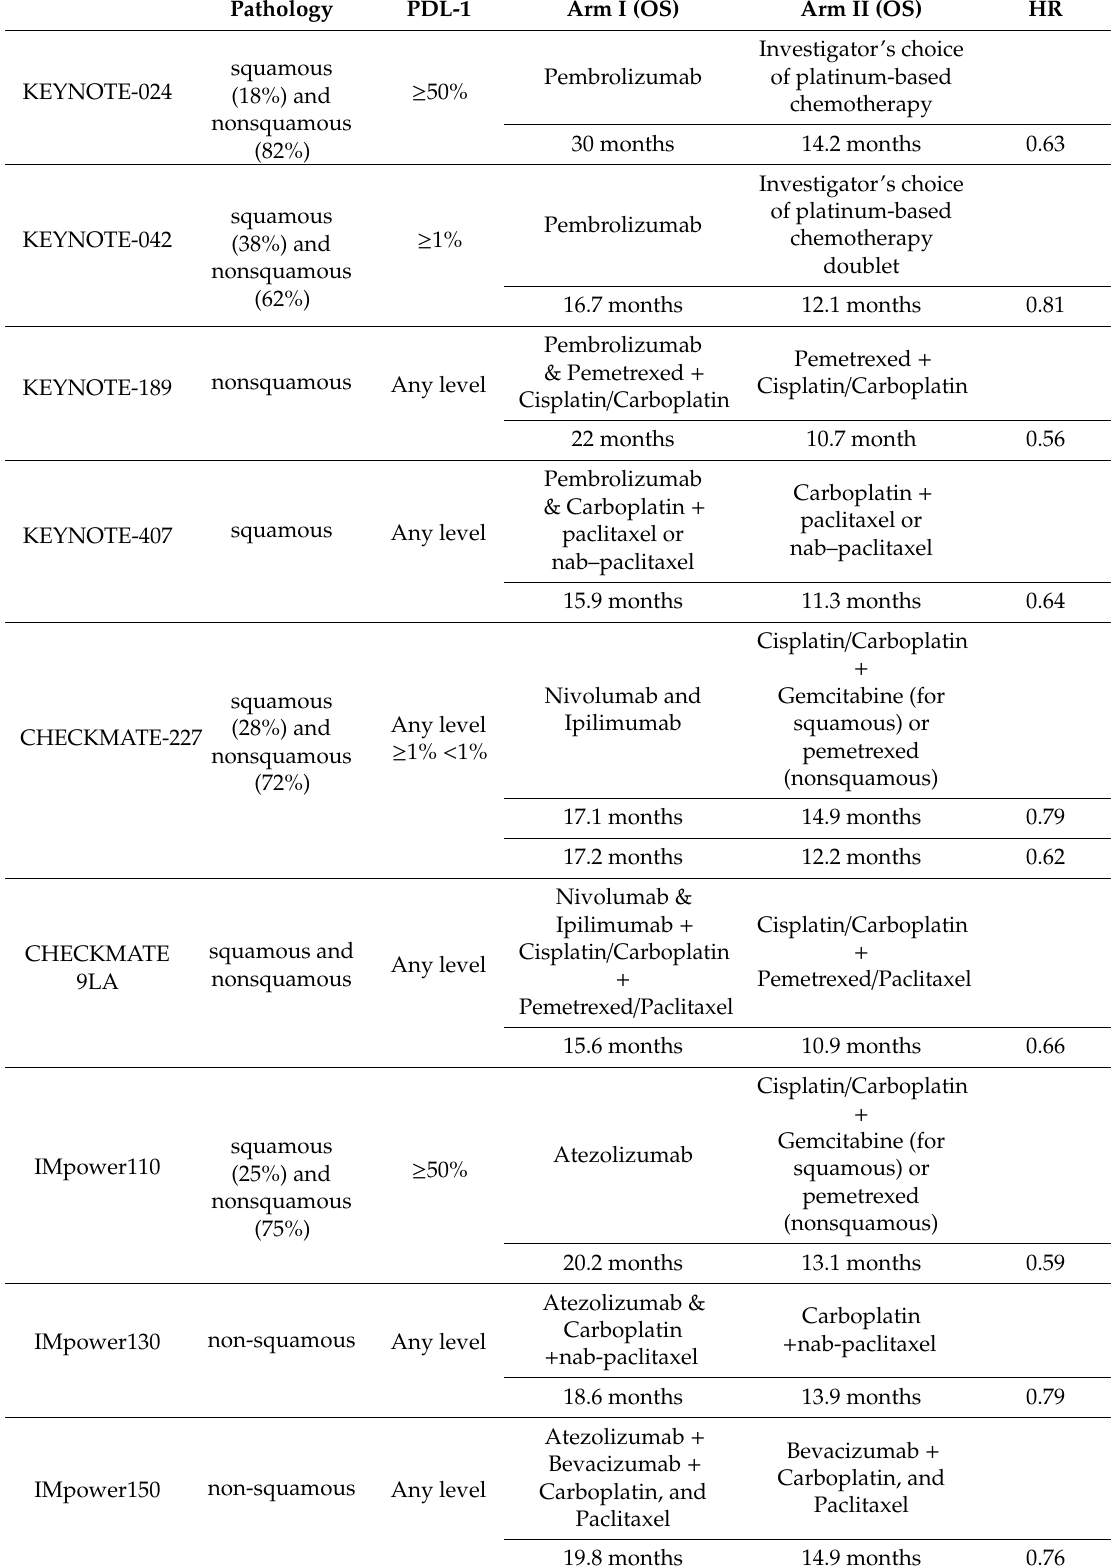
Table 2. Phase 3 clinical trials that includes Immunotherapy for NSCLC in the first